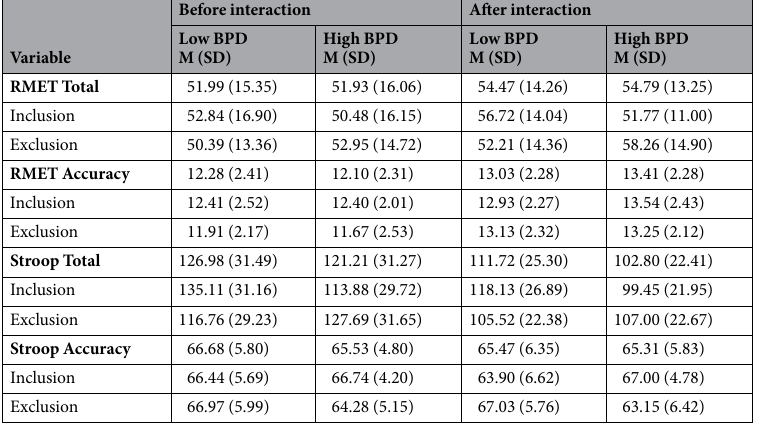
Table 1. Mean scores of two groups before and after the interaction. Note . PAIBOR = Personality Assessment Inventory-Borderline Feature scale. RMET = Reading the Mind in the Eyes Test.